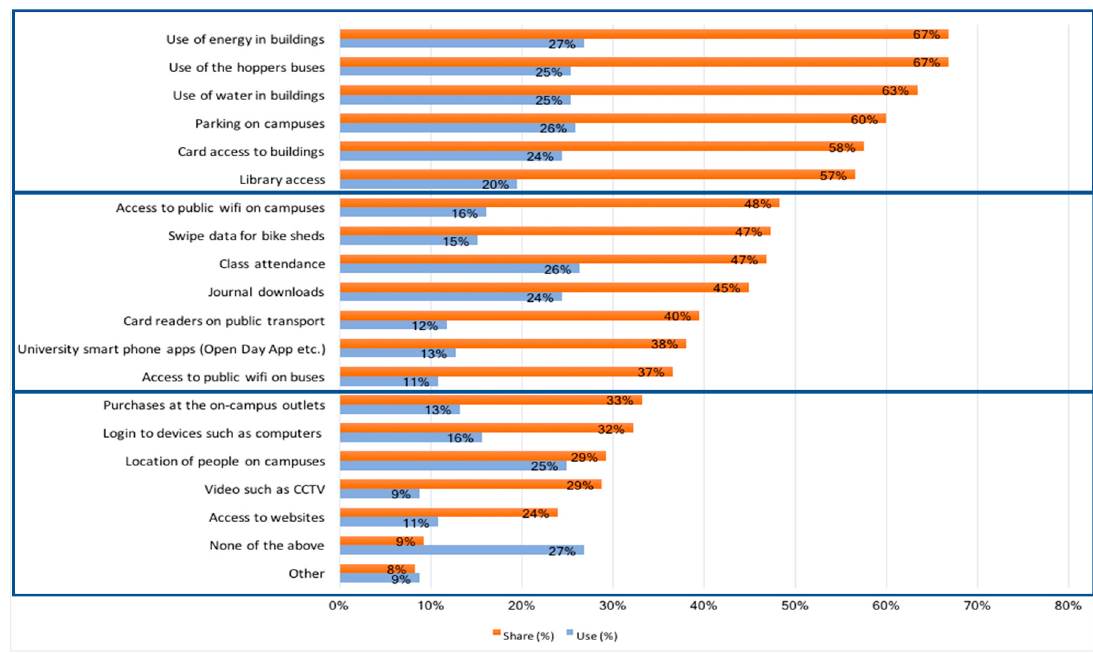
Figure 3. Perceptions of sharing data with third parties to improve services on campus (Share) in comparison to the interest in gaining access to the data (Use).